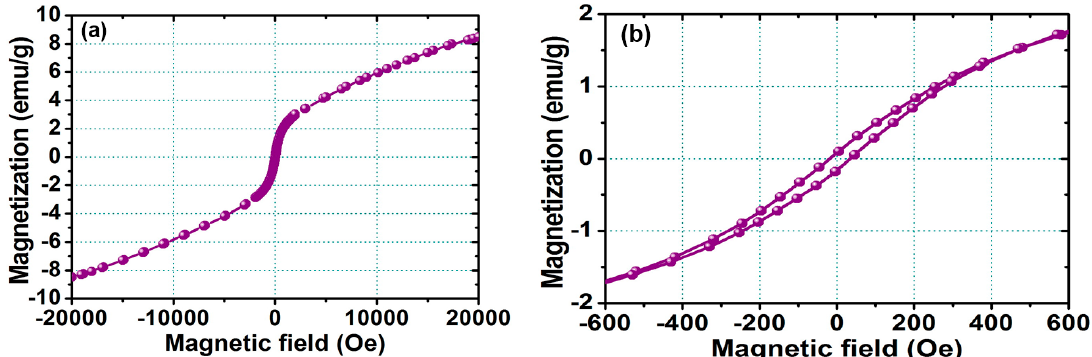
Figure 3. ( a ) Magnetization loop measured at room temperature for the FePt NPs measured at room